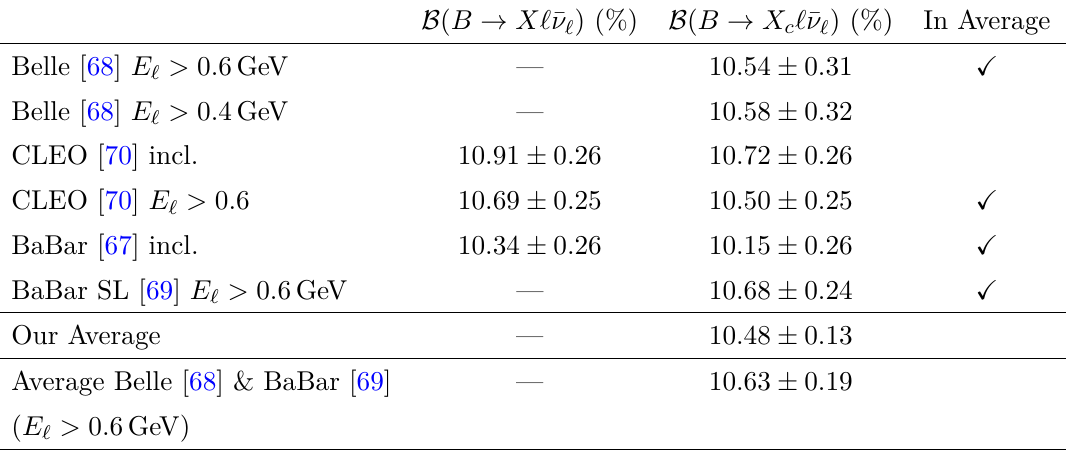
Table 2 . Available measurements of the inclusive B → X‘ ¯ ν ‘ and B → X c ‘ ¯ ν ‘ branching fractions, extrapolated to the full region using the correction factors in (3.13). The χ 2 of our average with respect to the included measurements is 2 . 2 , corresponding to a p-value of 52%. We do not in- clude [71], as the analysis does not quote a partial branching fraction corrected for FSR radiation.